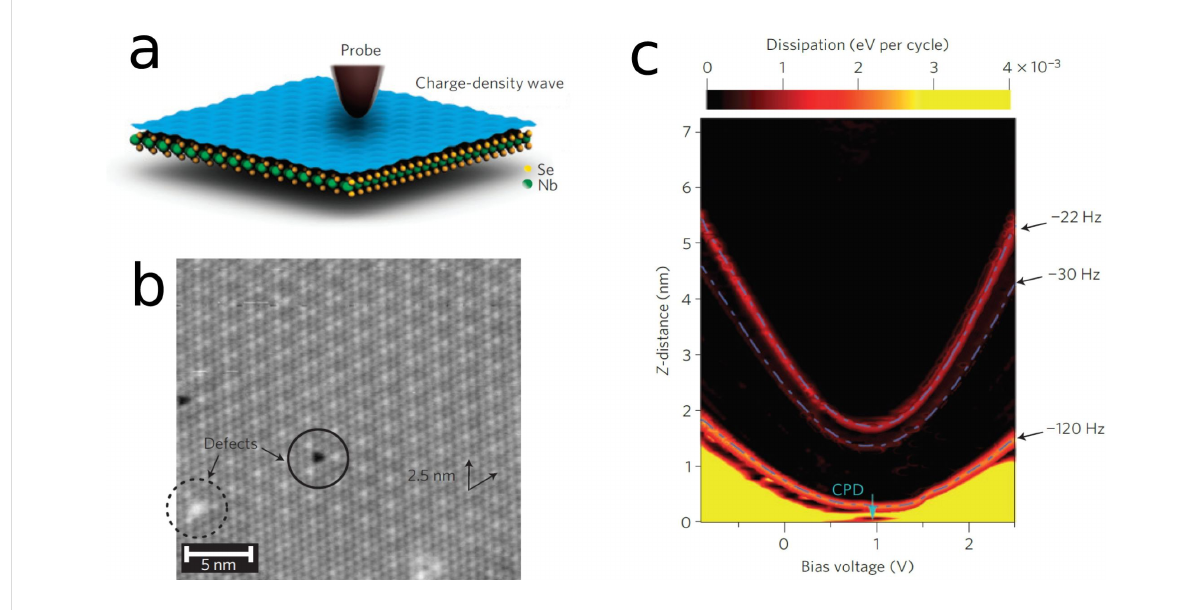
Figure 7: Non-contact friction experiments of NbSe 2 . At certain voltages and distances, one finds dramatically increased non-contact friction. This is related to the local disturbance of the charge-density wave, which leads to phase slips. a) Schematics of the probing tip above the charge-density wave system. b) STM image of the NbSe 2 -surface revealing the CDW. c) Non-contact friction dissipation as a function of distance and voltage. Reprinted with permission from [188], copyright 2013 Springer